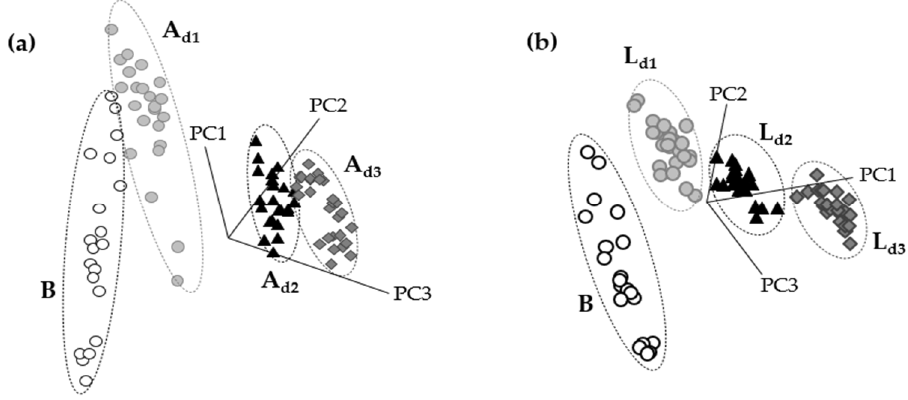
Figure 4. SIMCA class projection plots of ( a ) 4-class SIMCA A. diaperinus dough model and ( b ) 4-class SIMCA L. migratoria dough model. Abbreviations used: B, blank dough with 0% insect powder; A d1 , dough with 4.6% of A. diaperinus powder; A d2 , dough with 9.3% of A. diaperinus powder; A d3 , dough with 13.9% of A. diaperinus powder.